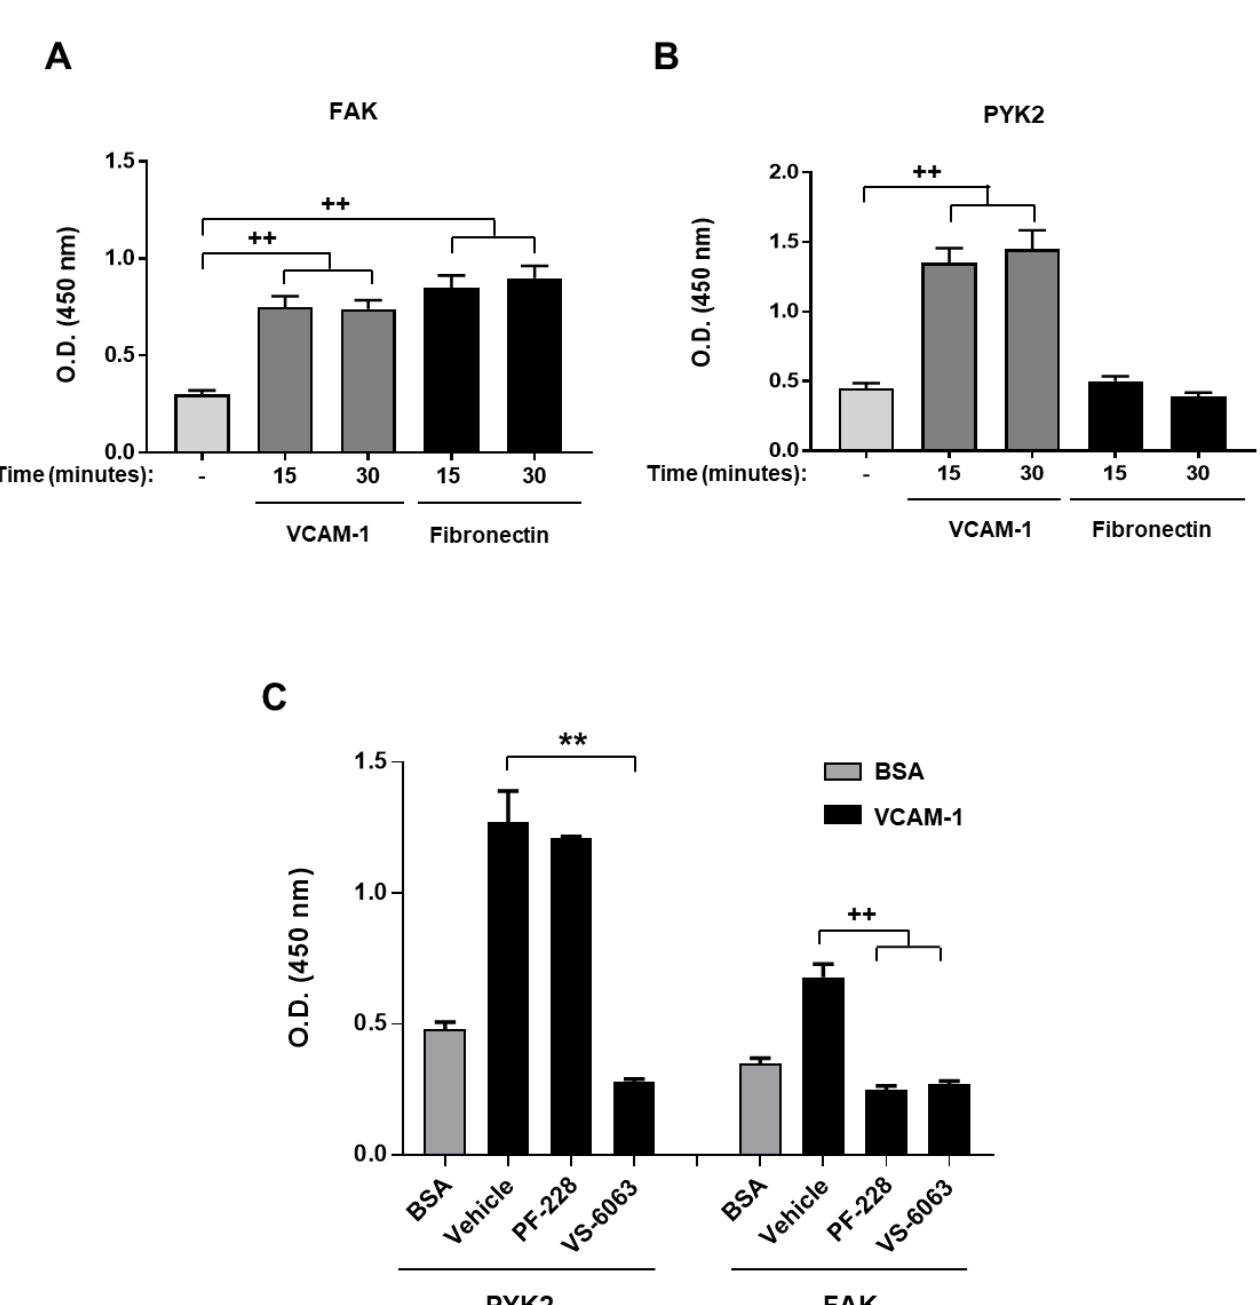
Figure 5. Differential activation of FAK and PYK2 in T-ALL cells. Jurkat cells were seeded on VCAM-1 or fibronectin for 15 and 30 min or on BSA ( − ) for 30 min. The cells were lysed and phosphorylation of FAK ( A ) and PYK2 ( B ) was determined by specific ELISA assays. ( C ) The cells were incubated with the vehicle ( − ) or with 0.5 µ M of the FAK inhibitor PF-228 and the dual FAK/PYK2 inhibitor VS-6063 for 1 h and then seeded on VCAM-1 for 30 min. FAK and PYK2 activations were then determined by ELISA assays. Results represent mean values ± S.D. of three independent experiments. ** p < 0.01 determined by the Student’s t -test. ++ p < 0.01 determined by the two-way ANOVA test.